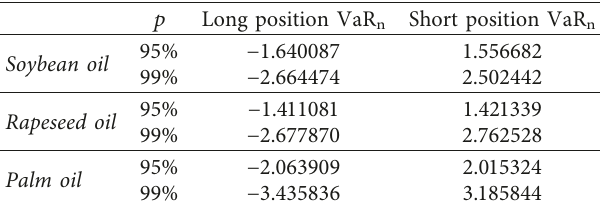
Table 8: VaRn estimation results.